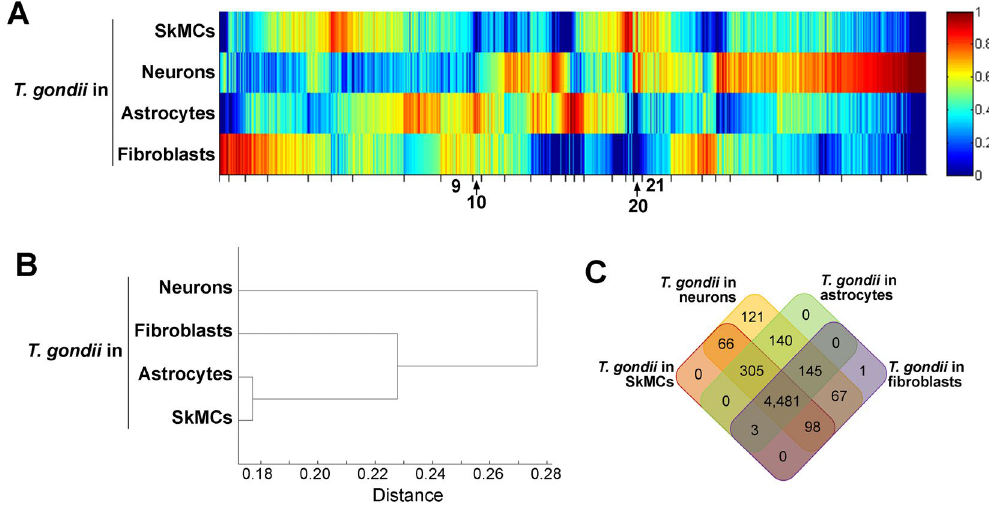
Figure 5. Heterogeneous gene expression in T. gondii after infection of mature SkMCs, neurons, astrocytes and fibroblasts at a MOI of 5:1 for 24 hours. Pools of total RNA from four different biological replicates each were used to prepare cDNA libraries which were then sequenced using Illumina technology. Reads were mapped to the T. gondii reference genome. Genes were identified the expression of which was differentially regulated depending on the host cell type (Chi 2 FWER < 0.01). ( A ) Heat map of T. gondii DEGs after infection of SkMCs, neurons, astrocytes and fibroblasts. Expression profiles were clustered according to a one-dimensional self- organizing map. Clusters of genes that were differentially expressed after infection of SkMCs and neurons as compared to astrocytes and fibroblasts are indicated by cluster numbers. ( B ) Hierarchical cluster analysis of genes differentially expressed after infection of the different host cell types. ( C ) Venn diagram of genes differentially expressed in T. gondii after infection of the different host cell